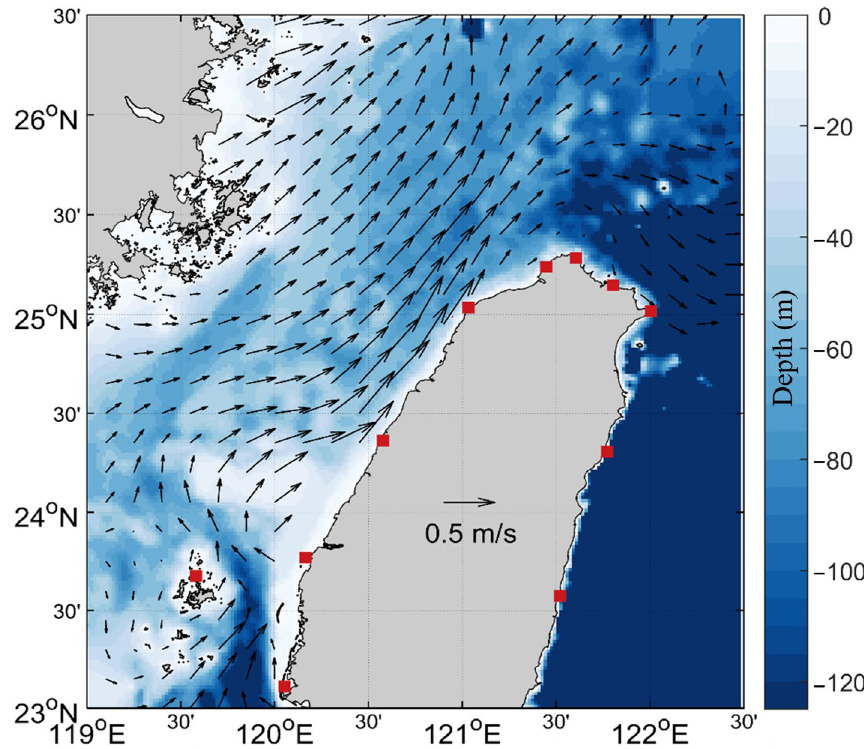
Figure 2. The average flow field in the summer of 2017 obtained from HF radar data. The red squares are the positions of CODAR stations around Taiwan.